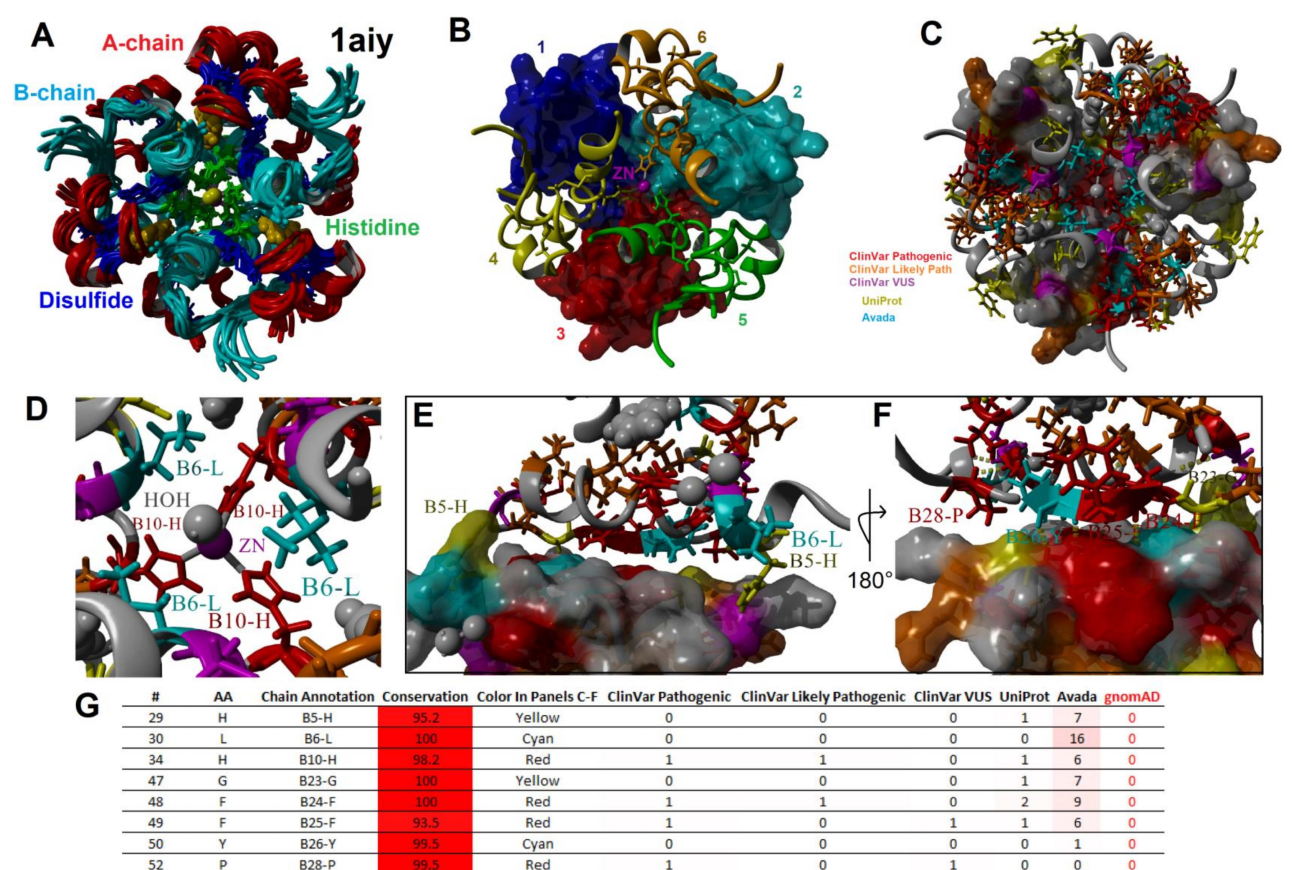
Figure 7. Mapping variants to the multimeric state of insulin. ( A – C ) The PDB file 1aiy shown in the same orientation but colored various ways. Panel A shows the A-chain in red, B-chain in cyan, disulfide bonds in blue, histidine in green, and zinc in magenta for the top ten predicted models of the NMR structure. Panel B shows the top model of Panel A for the six different insulin molecules (both A- and B-chains) in different colors, with the first zinc coordination site molecules shown as surface plots and the other zinc sites as ribbon plots. Panel C uses the same coloring as Figure 6D for human variants. ( D ) A zoomed view of one Zn coordination site using the coloring of Panel C for human variants. Labeled residues are those that make contact between multiple subunits. ( E , F ) Zoomed view of contact residues between different insulin molecules. Labeled amino acids have a human variant. Panel F is a 180-degree rotation of Panel E. ( G ) Table of missense variants forming contacts within the hexamer